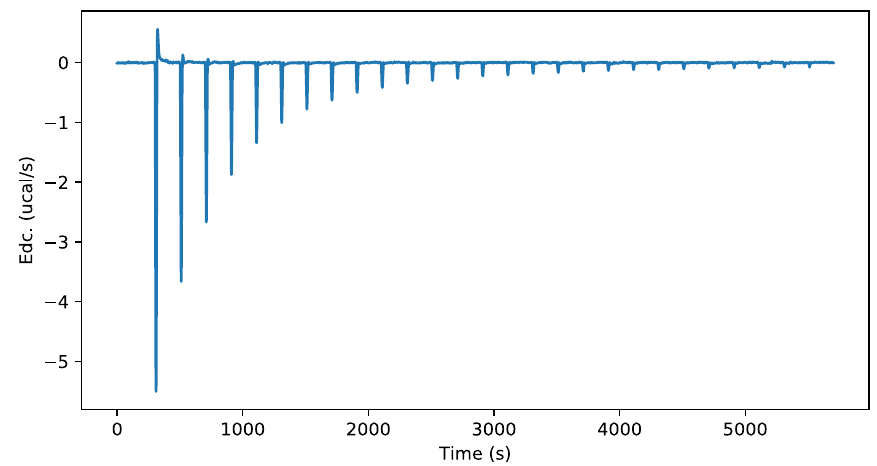
Figure 1. Plot of the deconvolved power trace (Edc) of bindings between a decavalent Con A and a bivalent precision glycomacromolecule over time and through 14